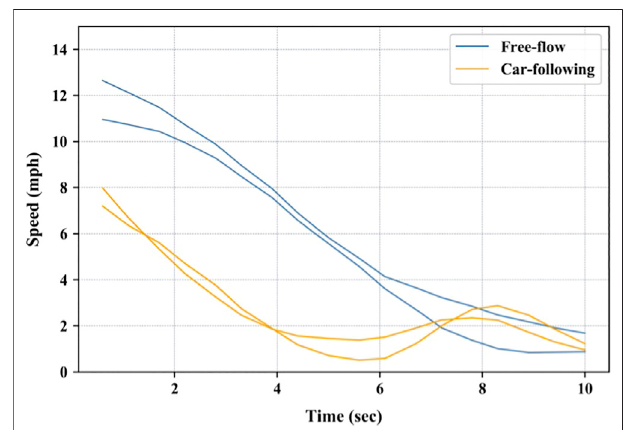
FIGURE 2 | Speed patterns under two different driving